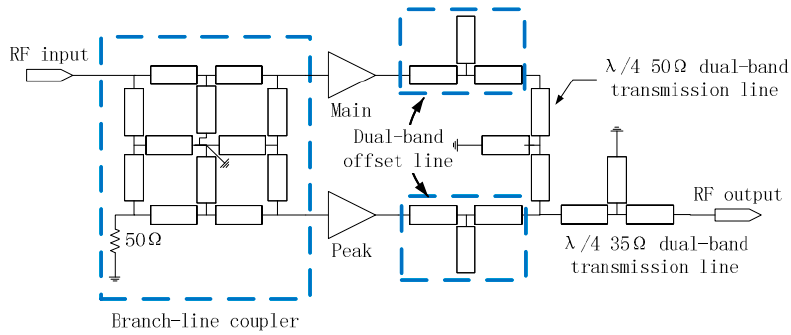
Figure 7. Dual-band DPA schematic [7].